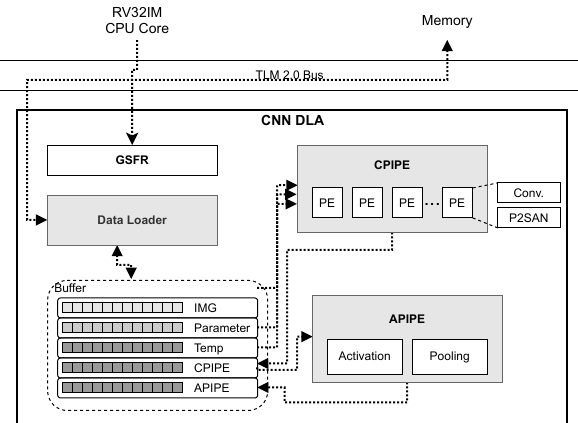
Figure 2. The overall structure and Interface of the CNN DLA